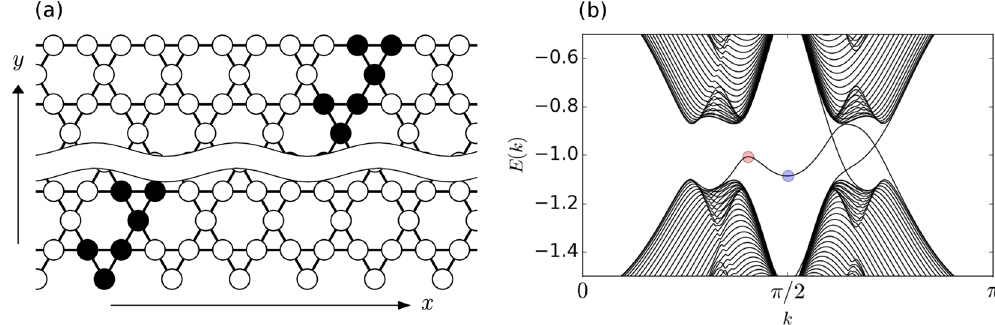
Figure 1. ( a ) A strip of kagome lattice. The strip is infinite along x but has a finite extent along the y axis. The sites marked by black form a unit cell of the strip. The bottom boundary of the strip with a row of uncoupled sites supports the dispersion of topological edge mode with the group velocity changing sign within the bulk gap as shown in Figure b. ( b ) Band structure for exciton-polaritons in a strip of kagome lattice. Dispersion of edge states with reversed group velocity and a well defined minimum and maximum lying within the bulk gap appears for a certain range of values of the magnetic field and TE-TM splitting at the lower boundary made of sites without the nearest neighbor hopping (the bottom one in Figure a): in this example, Ω = 0.3 and δ J = 0.15 in normalized units. The red and blue dots mark the regions where nonlinear solutions in the form of bright and dark solitons are sought. The band structure beyond the edge of the first Brillouin zone at π /2 is shown for better display of the topological edge state